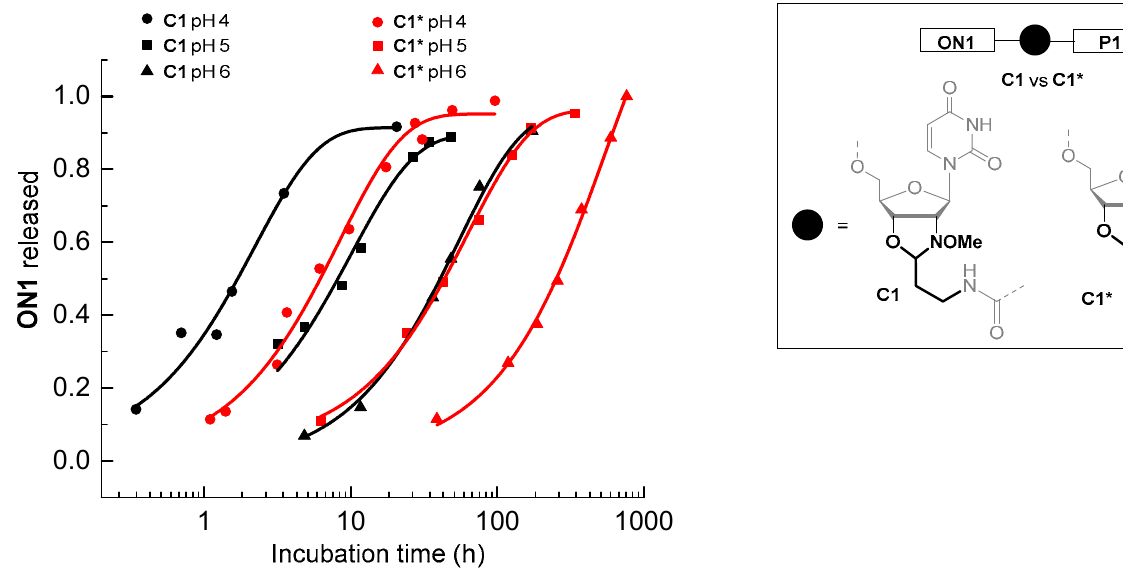
Figure 3. Comparison of the structures and hydrolysis rates of the analogous C1 and C1*.